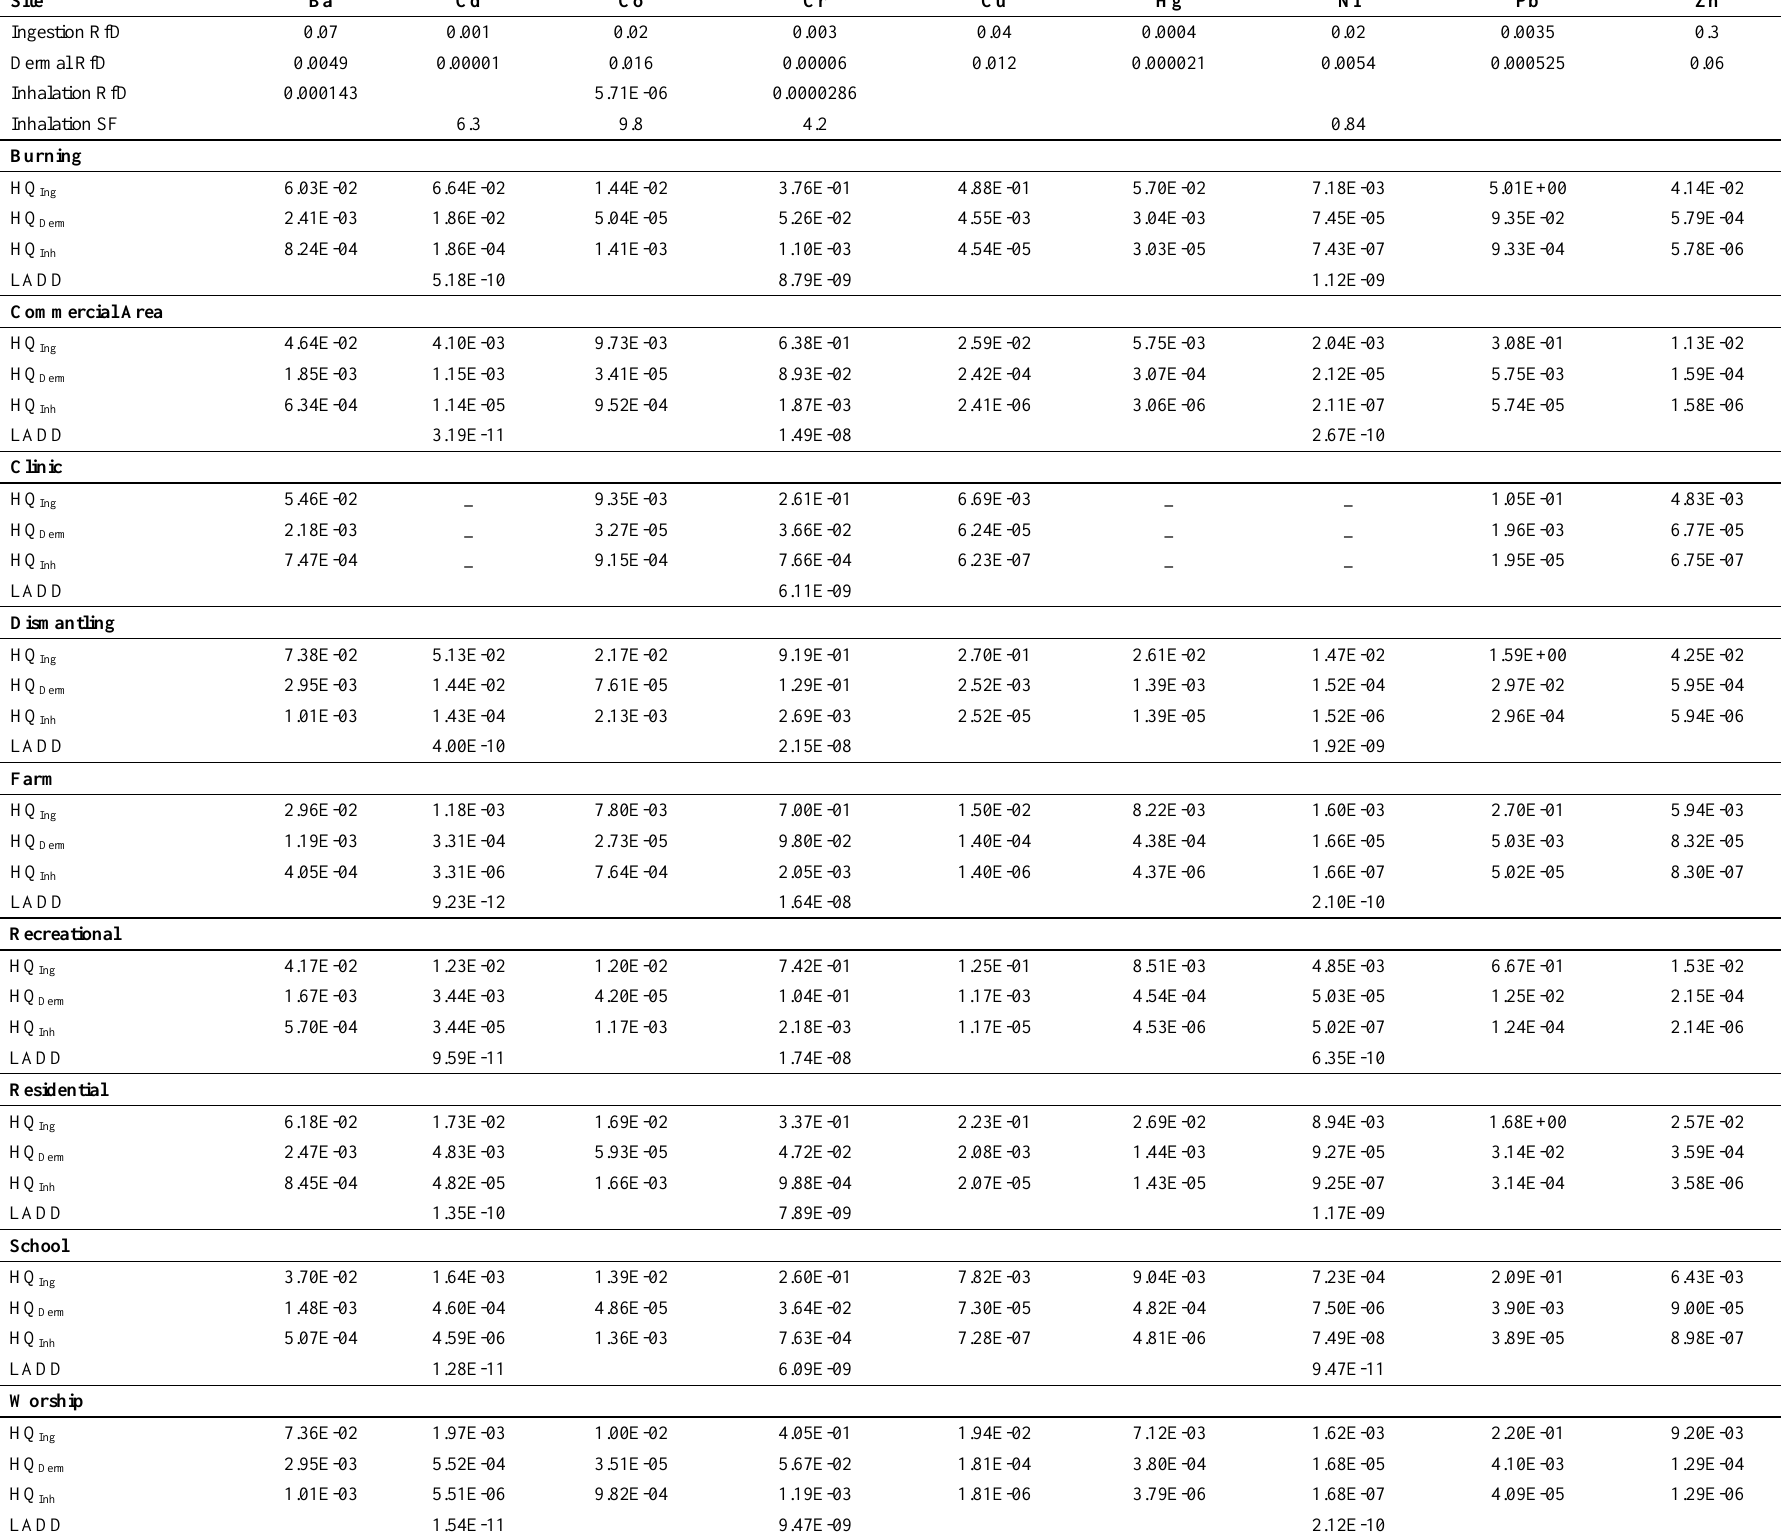
Table 2. Hazard quotient and heavy metal intake of each element and exposure pathway